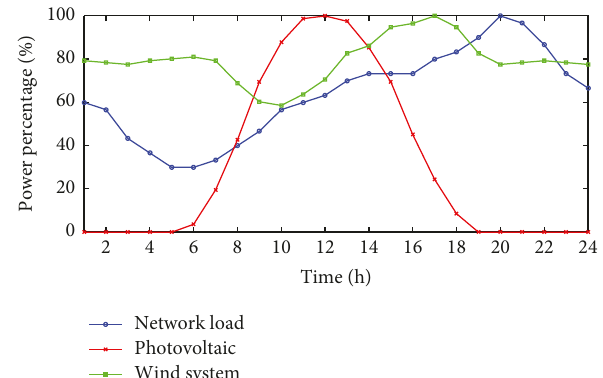
Figure 5: Forecasted power percentage of RES and network load